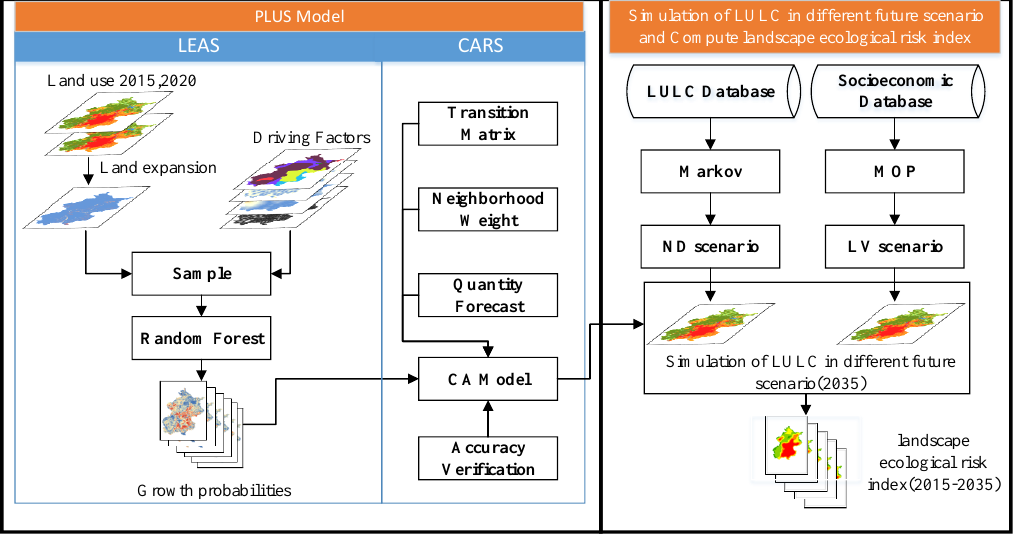
Figure 2. Technical flow chart.